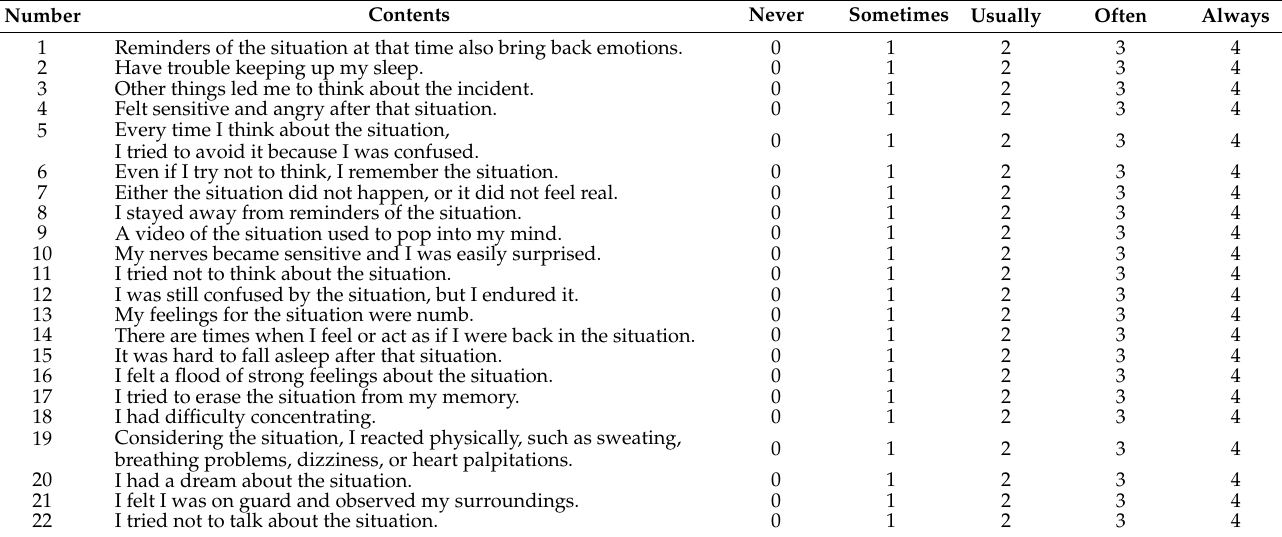
Table 1. Psychological first-aid assessment